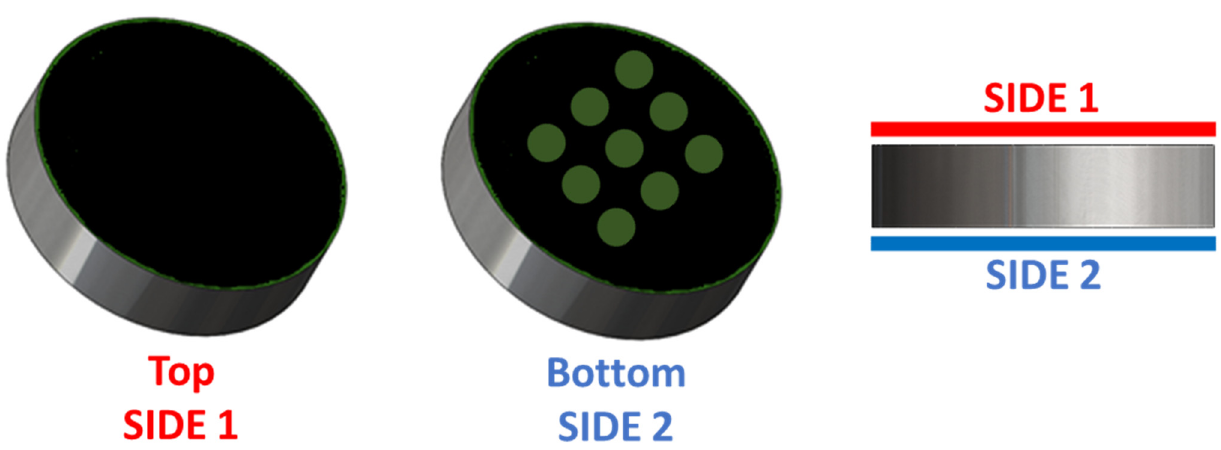
Figure 2. The division of the ZnO ceramics turning operations into two sides, illustrative of the uniaxial pressing of green compacts prior to the sintering operation.